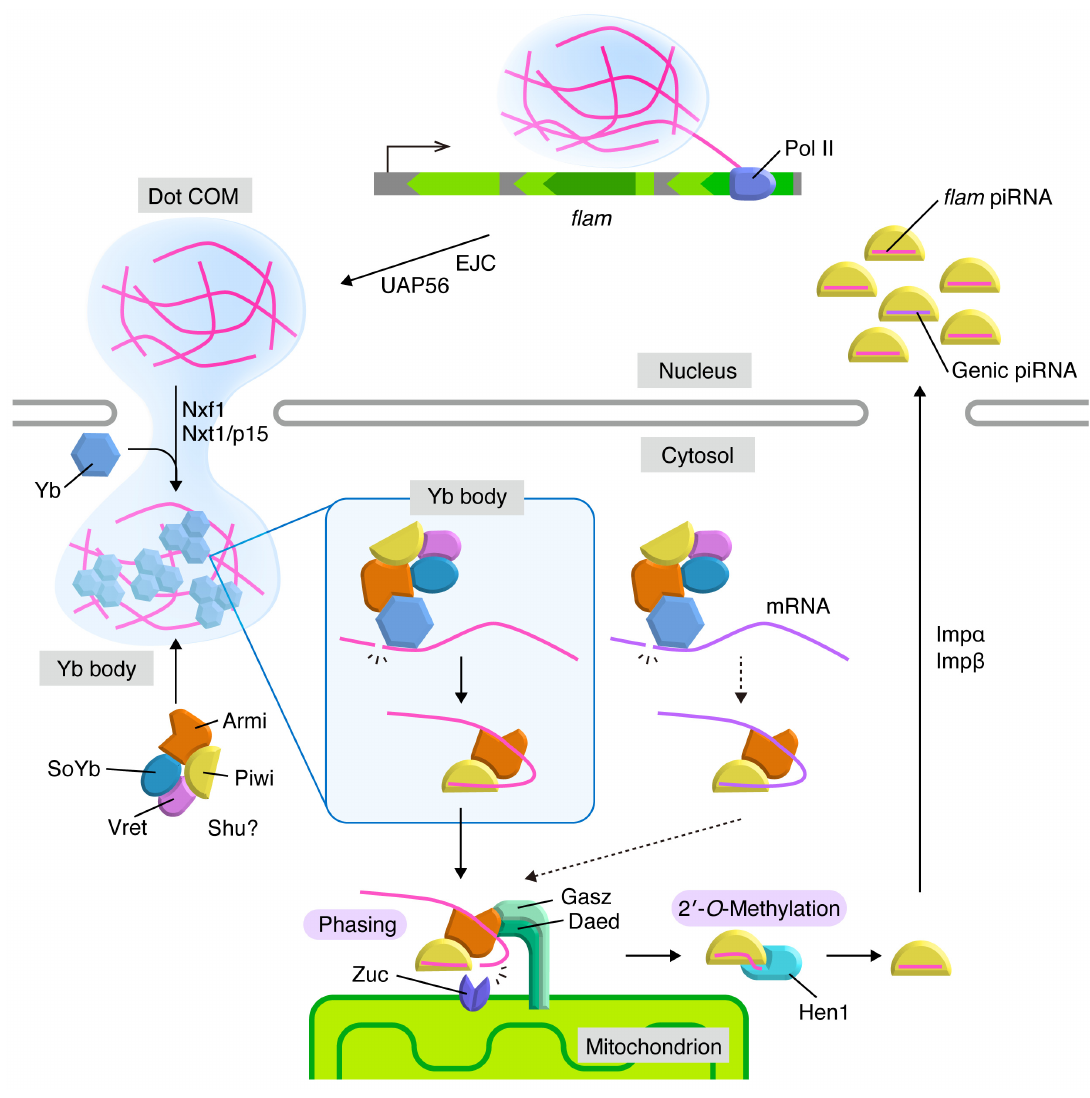
Figure 2. piRNA biogenesis pathway in Drosophila ovarian somatic cells. Transcripts of flam (magenta) generate Dot COM in the nucleus and are translocated to nuclear periphery in a manner dependent on Exon Junction Complex (EJC) and UAP56. Dot COM is exported to the cytoplasm by the Nxf1-Nxt1 / p15 complex. In the cytoplasm, flam transcripts are processed into piRNA intermediates in Yb bodies. Yb and flam require each other for granularization in the cytoplasm. The Armi-Piwi-piRNA intermediate complex moves to the surface of the mitochondrial outer membrane, where phased piRNAs are produced in mature lengths by endoribonuclease Zuc. After Hen1-mediated 2 (cid:48) - O -methylations at the piRNA 3 (cid:48) ends, piRISCs are imported into the nucleus, where they co-transcriptionally repress their targets. Some mRNAs (violet) are also processed into piRNA intermediates in the cytosol at low e ffi ciency and generate genic piRNAs through phasing on mitochondria. The targets and functions of genic piRNAs are vague.